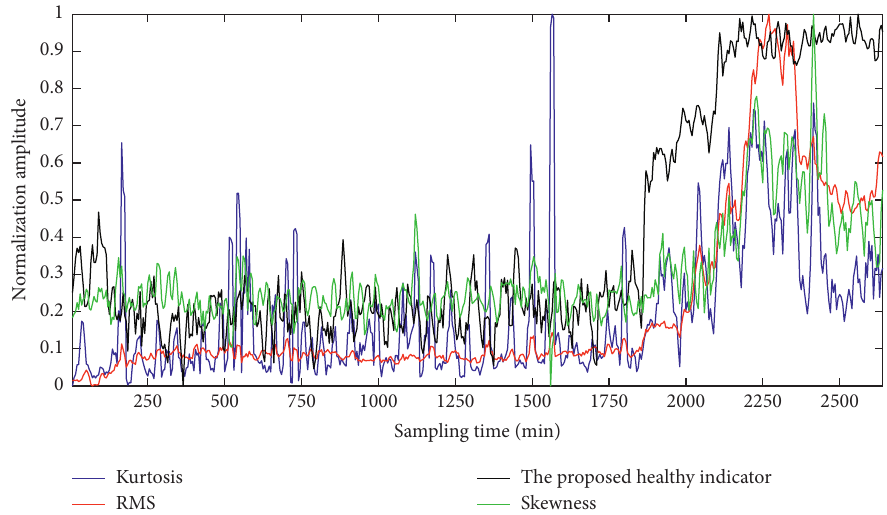
Figure 15: Comparison with three indicators: Kurtosis, skewness, and RMS.